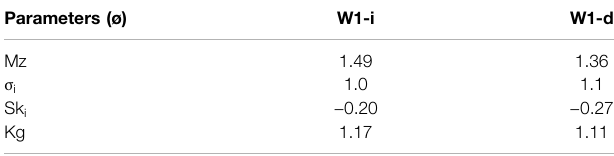
TABLE 4 | Grain size parameters of MPs in different sources in